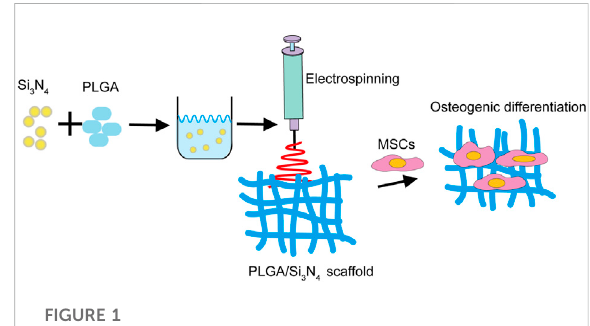
FIGURE 1 Schematic diagram of the PLGA/Si 3 N 4 nano fi ber